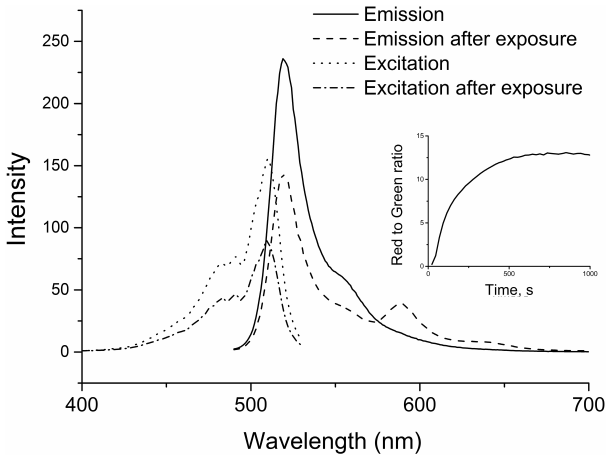
Fig. 5. Emission and excitation spectra of the green form of SAASoti. Change of green form to red form °uorescence in- tensity ratio (R:G) in the course of 405 nm laser irradiation. Inset — Time-course of the green to red °uorescence conversion shown as a red to green ratio.